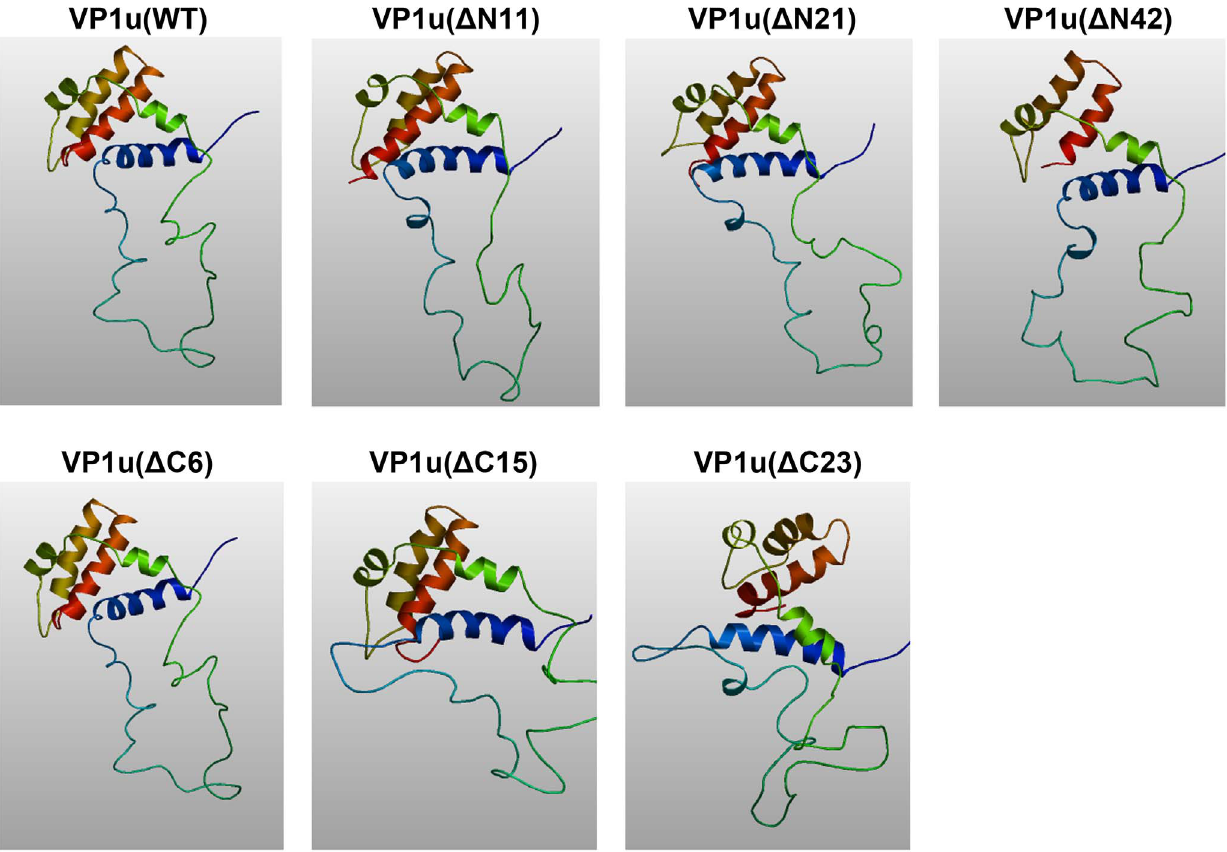
Figure 3. Predicted 3D structure of wild type and truncated VP1u. WT and truncated VP1u amino acid sequences were analyzed by homology modulation using the (PS) 2 program. The 3D images were generated with the program AstexViewer.